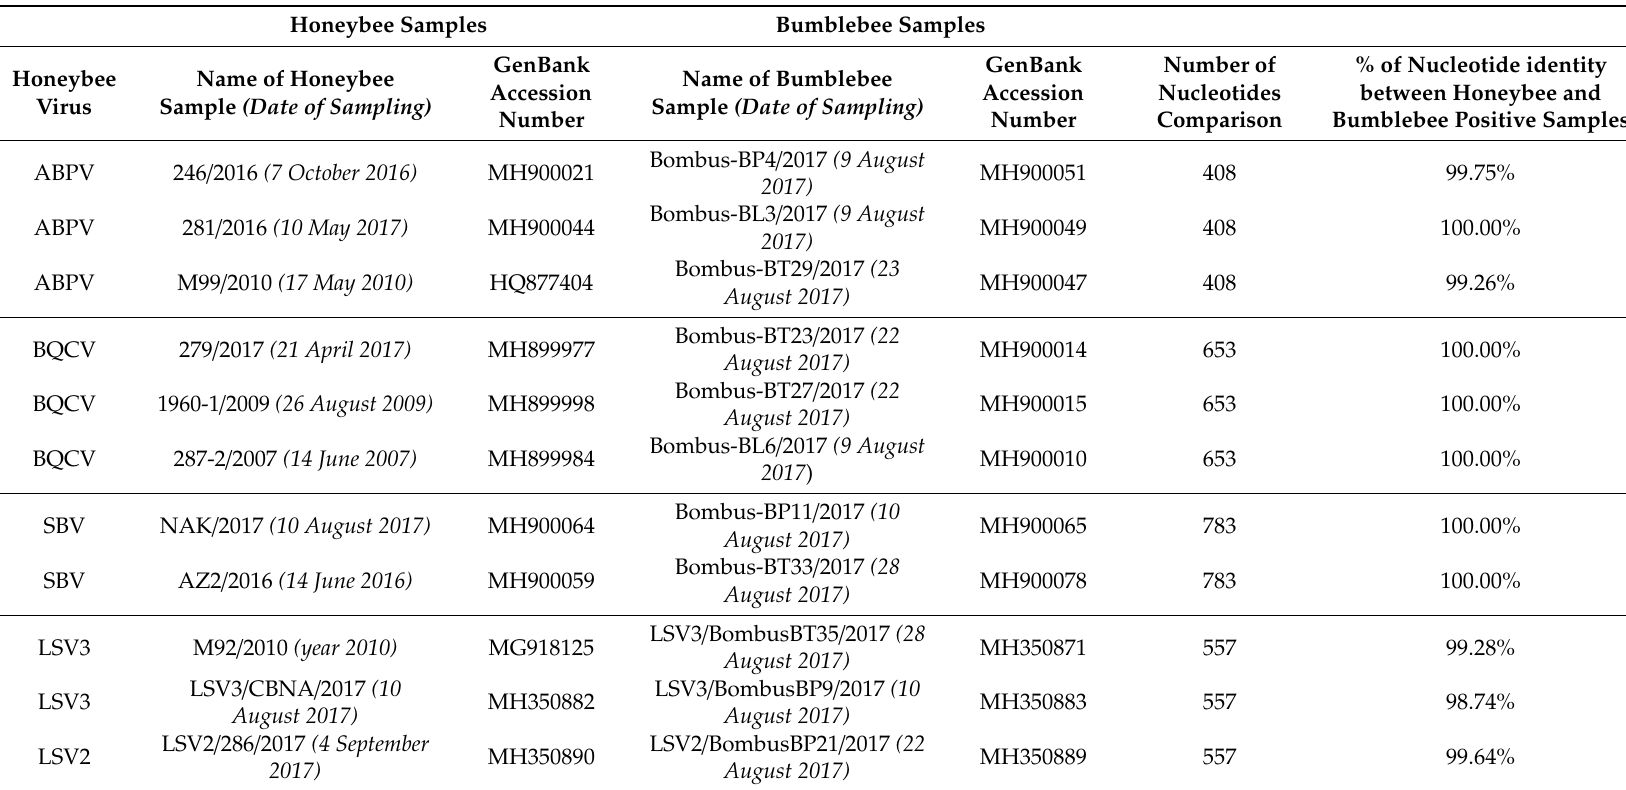
Table 2. The representatives of most closely related strains with high nucleotide identity observed for ABPV, BQCV, SBV and LSV among bumblebees ( Bombus spp.) and honeybees ( Apis mellifera ) positive